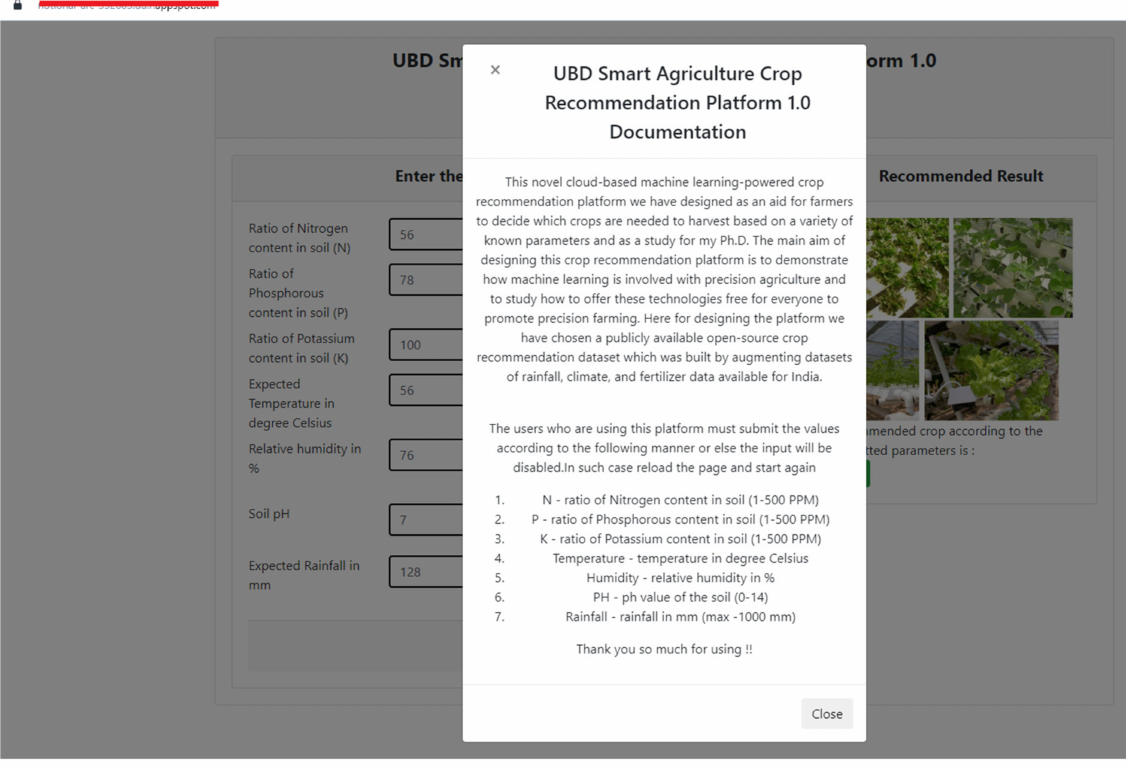
Figure 12. Cloud-hosted crop recommendation platform user